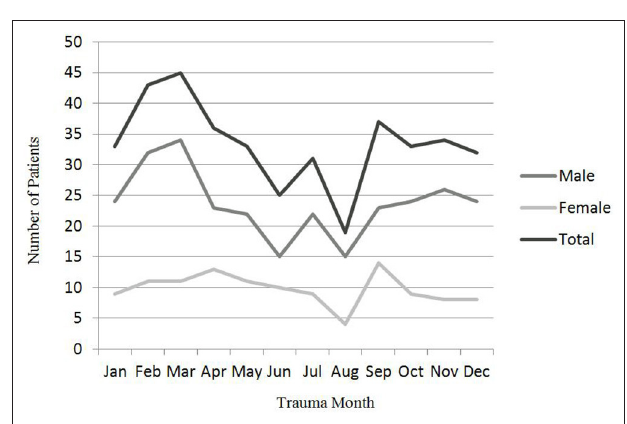
FIGURE 2 | Sex and trauma month distribution of OGI in